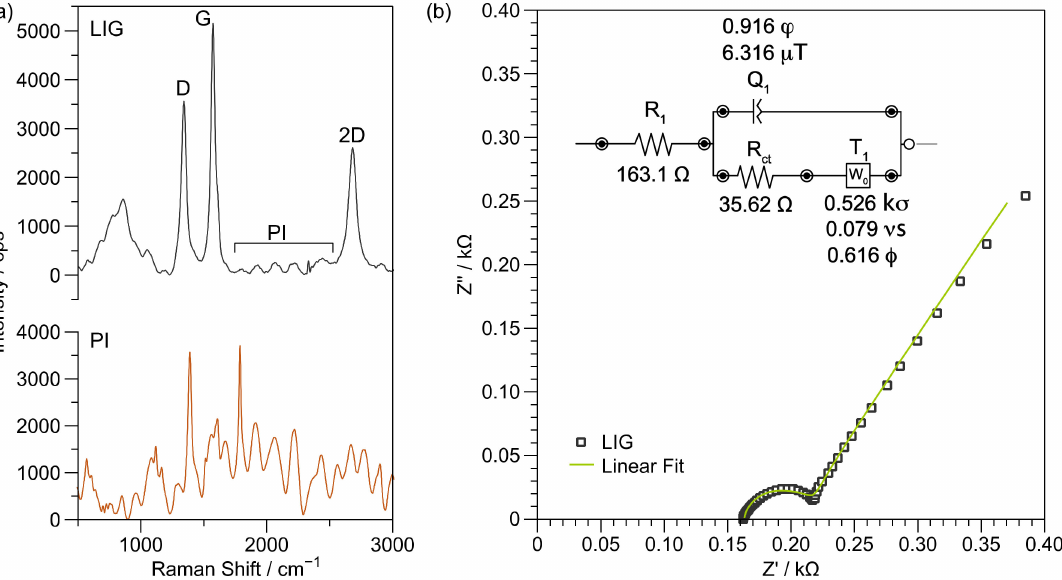
Figure 3. ( a ) Comparison of Raman spectra of LIG and PI; ( b ) EIS Nyquist plot of LIG-based three- electrode